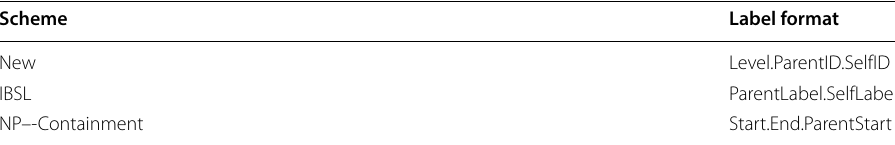
Table 2 Label format of schemes